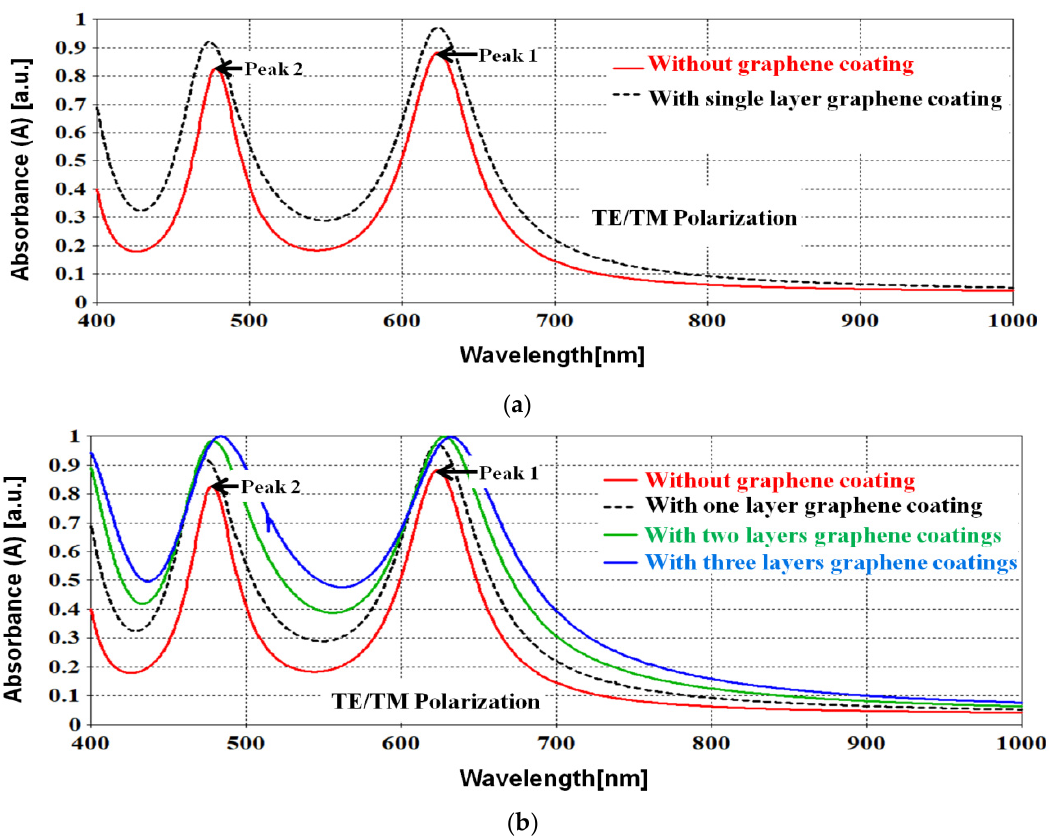
Figure 3. Comparison of absorbance spectra of the proposed model without and with graphene coatings; ( a ) proposed model without graphene layer coating (red curve) and with single layer graphene coating (black dashed curve); ( b ) for N = 0, 1, 2, and 3 layers (where N is the number of graphene layers).